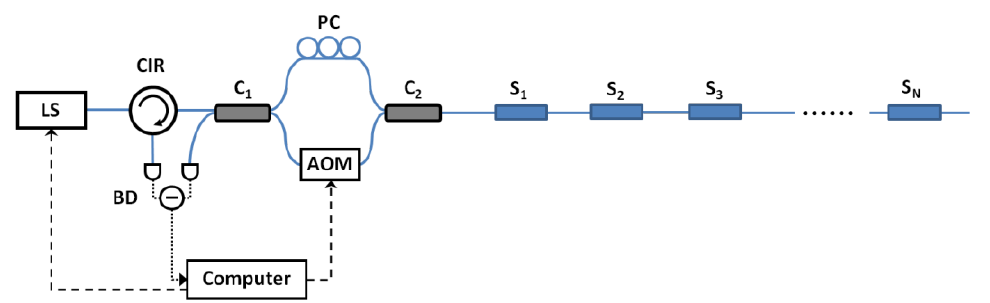
and C : 50/50 fiber directional 1 2